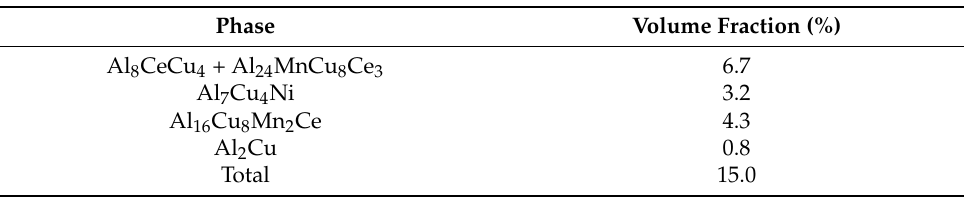
Table 5. The volume fraction of intermetallic compounds phases at the grain boundaries and interdendritic areas in the 0.5 Ni